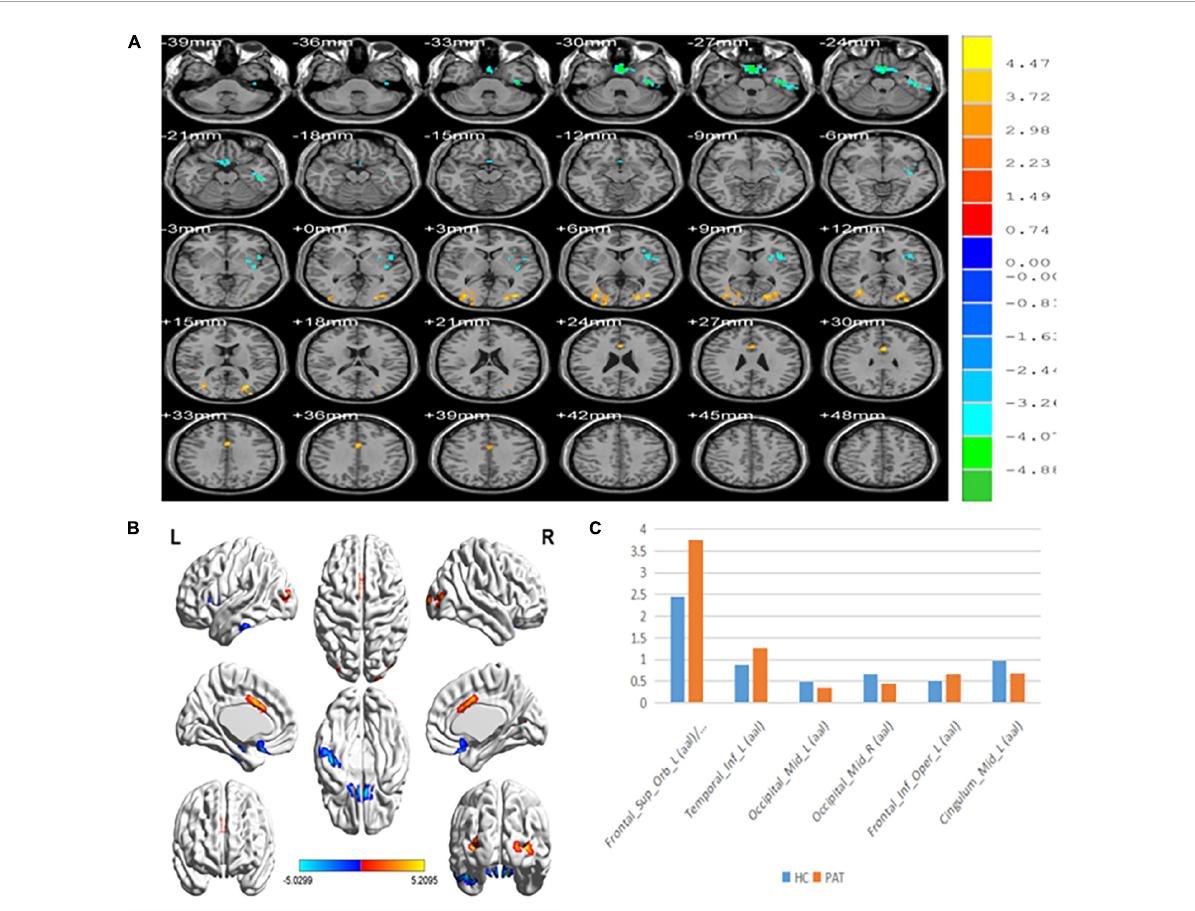
FIGURE1 (A,B) Spontaneous brain activity in the MB patients and the HC group. (C) The mean PerAF signal value between the MB and HC groups. Warmer shades (yellow and red) represent moderate and high signal strength, respectively and blue represents lower signal strength. The signal values of Frontal_Sup_Orb_L/Frontal_Inf_Orb_L/Temporal_inf_L/Frontal_Inf_Oper_L regions in MB patients are higher than in controls, and on the contrary, the signal valuse of Occipital_Mid_L/Occipital_Mid_R/Cingulum_Mid_L are lower than controls. PerAF, percent amplitude of fluctuation; MB, monocular blindness; HCs, healthy